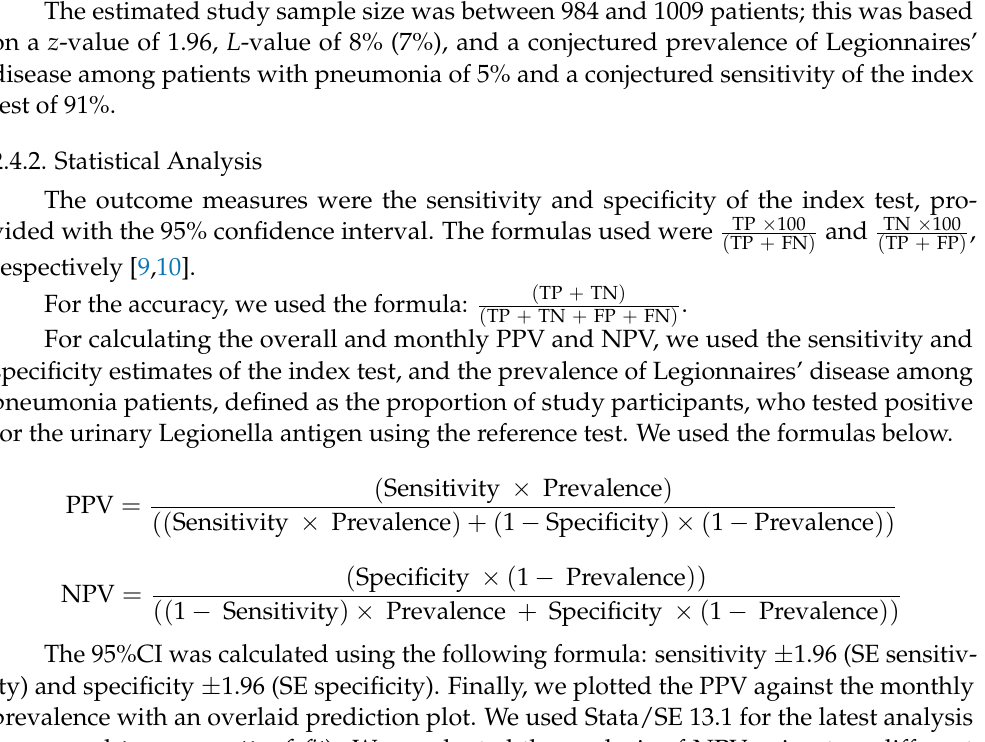
Table 1. Comparison of the Legionella test method results.